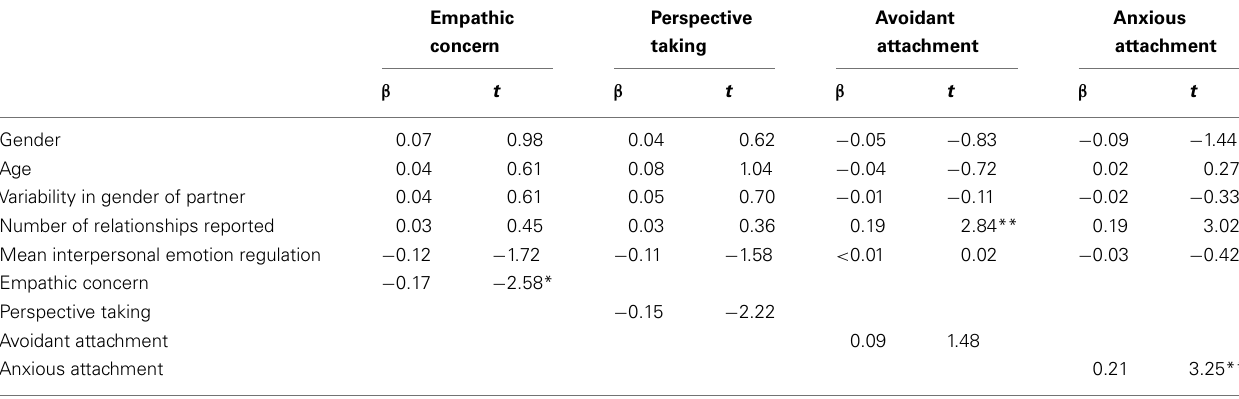
Table 5 | Regression of individual difference variables onto spin.